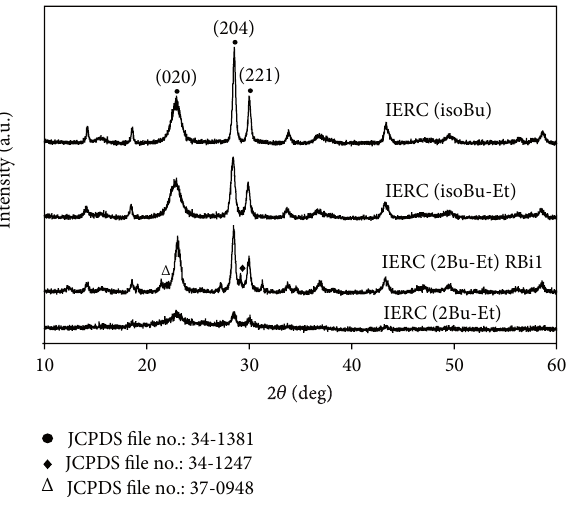
F 2: XRD patterns for IER-VPD